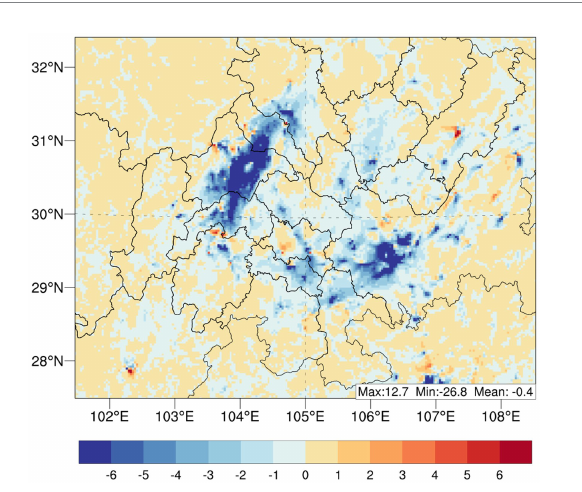
FIGURE 9 Differences in simulated NO 2 between 2019LULC and WRF_default scenarios at night over the SCB in August